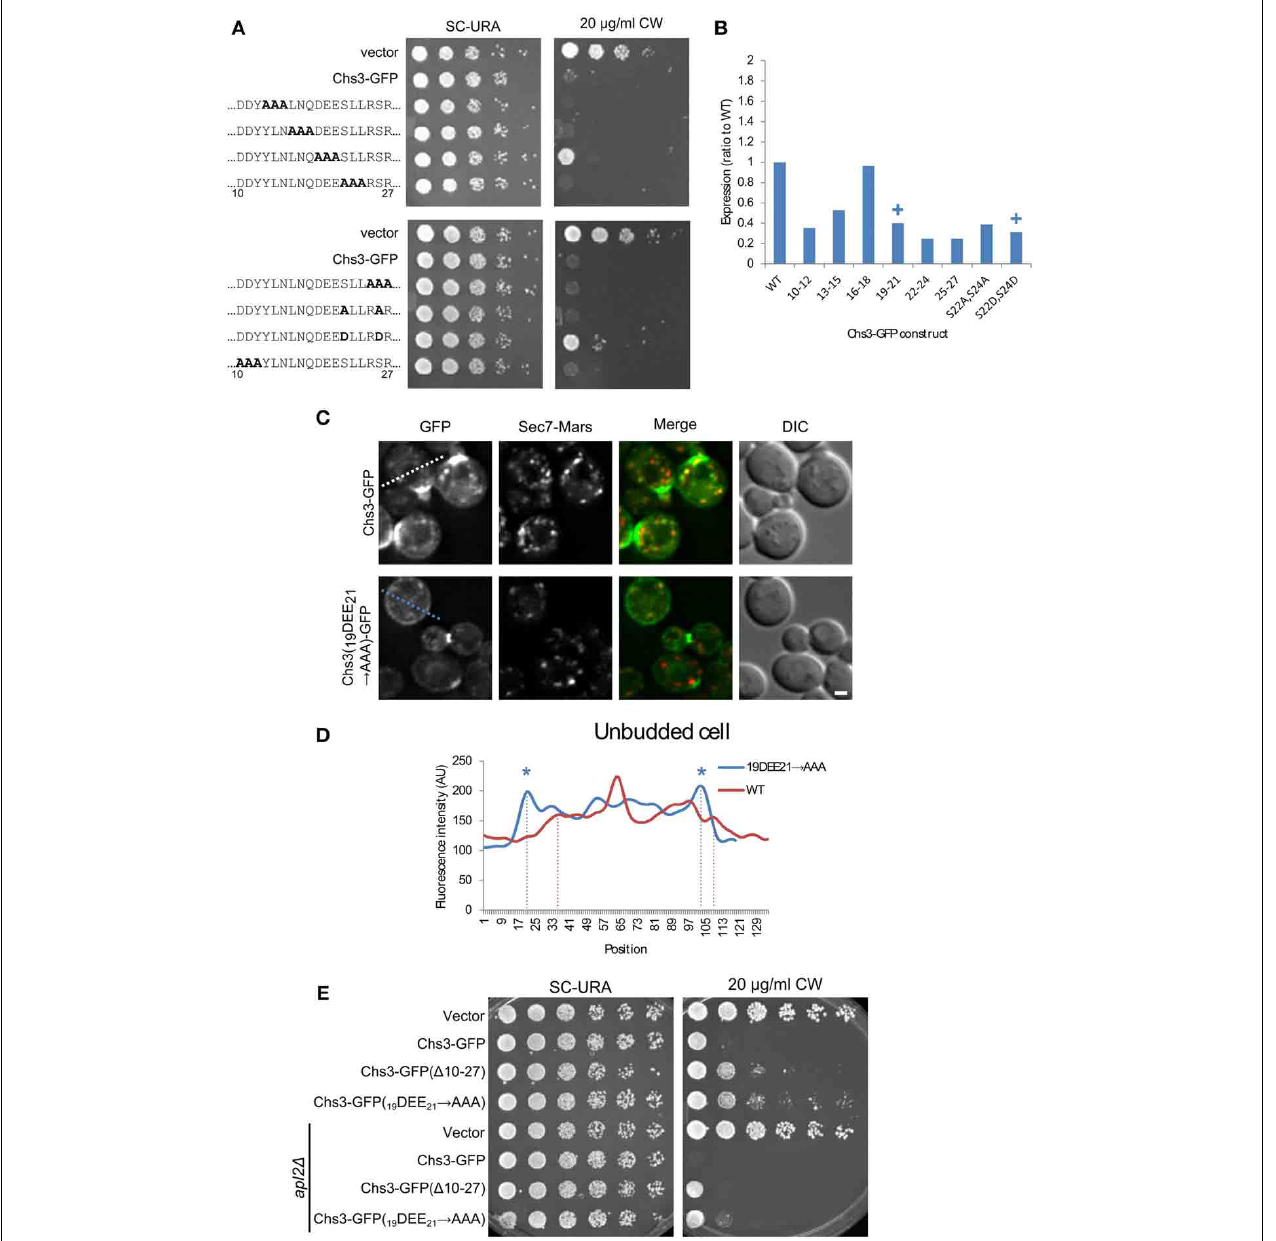
FIGURE 3 | Mutation of Chs3 residues 19–21 causes a defect in internalization. (A) Chs3-GFP plasmids containing alanine scanning mutants were transformed into a chs3 (cid:2) SEC7-Mars strain and plated on indicated concentrations of CW. Plates were imaged after 2 days at 30 ◦ C. See also Figure S2 for additional CW concentrations. (B) Protein expression level of alanine-scanning Chs3-GFP constructs relative to wild type as calculated from the α -GFP Western blots in Figure S1, normalized to loading control. Mutations that confer CW resistance phenotypes are marked with ( + ). (C) GFP and Sec7-Mars localization in chs3 (cid:2) cells for